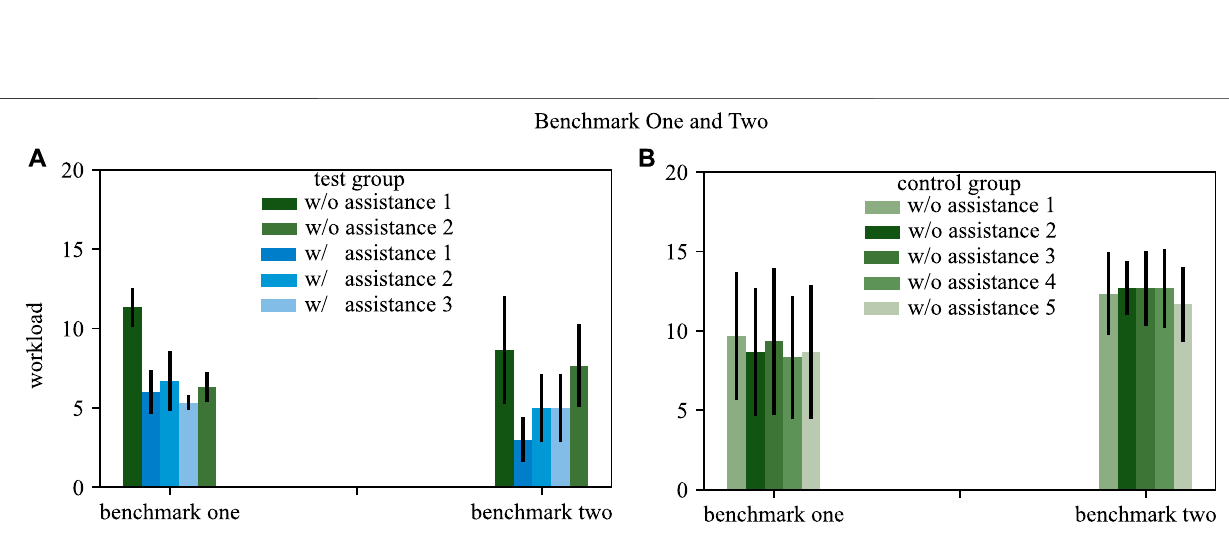
Frontiers in Robotics and AI |